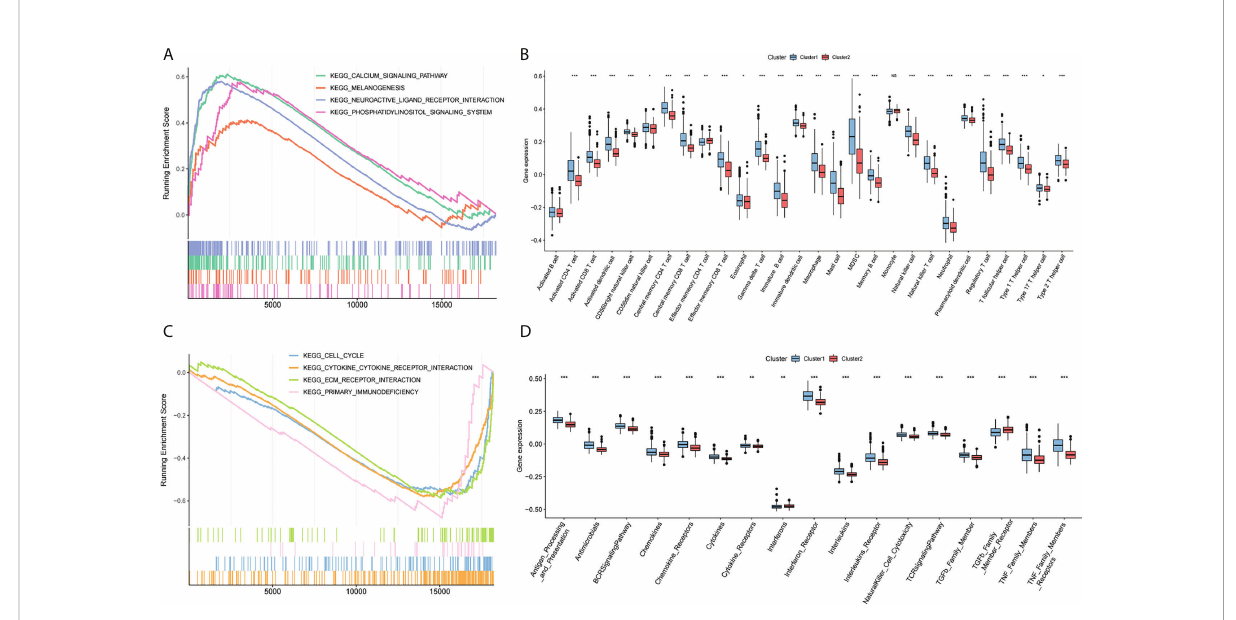
FIGURE 5 GSEA analysis. (A) Calcium signaling pathway, melanogenesis, neuroactive ligand-receptor interaction, and phosphoinositol signaling system are signi fi cantly enriched in cluster2. (B) Box plot of the difference of immune in fi ltration abundance between cluster1 and cluster2. The horizontal axis represents immune cells, the vertical axis represents immune cell in fi ltration abundance, blue represents cluster1, and red represents cluster2. (C) Cell cycle, primary immunode fi ciency, cytokine receptor interaction, and extracellular matrix-receptor interaction are signi fi cantly enriched in cluster1. (D) Box plot of cluster1 and cluster2 and immune function set score. The horizontal axis represents the immune function set, the vertical axis represents the immune function set score, blue represents cluster1, and red represents cluster2. (NS:no signi fi cant) (*P < 0.05, **P < 0.01, ***P <